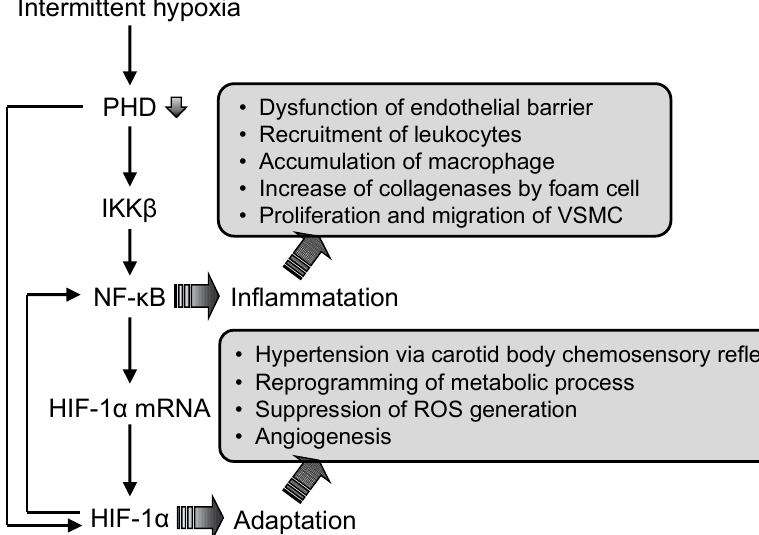
Figure 2. Model of the hypoxia-inducible factor (HIF)-1 and nuclear factor (NF)- κ B activation mechanisms in response to intermittent hypoxia (IH). IH-induced hypoxic condition decreases PHD activity. As a result, NF- κ B is induced to activate via the activation of I- κ B kinase- β (IKK β ), which activates both the NF- κ B mediated inflammation pathway and the NF- κ B mediated up-regulation of HIF-1. Activation of NF- κ B and HIF-1 induces inflammation and adaptation to IH, resulting in angiogenesis via the proliferation and migration of VSMC. PHD: prolyl hydroxylases.